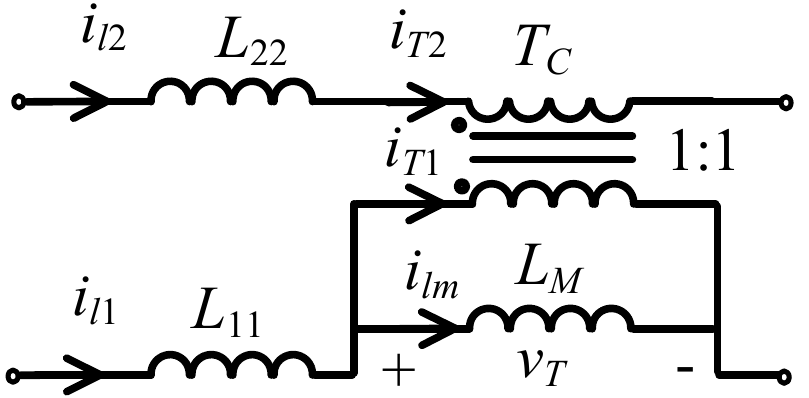
Figure 3. Simplified transformer model of the coupled inductor.